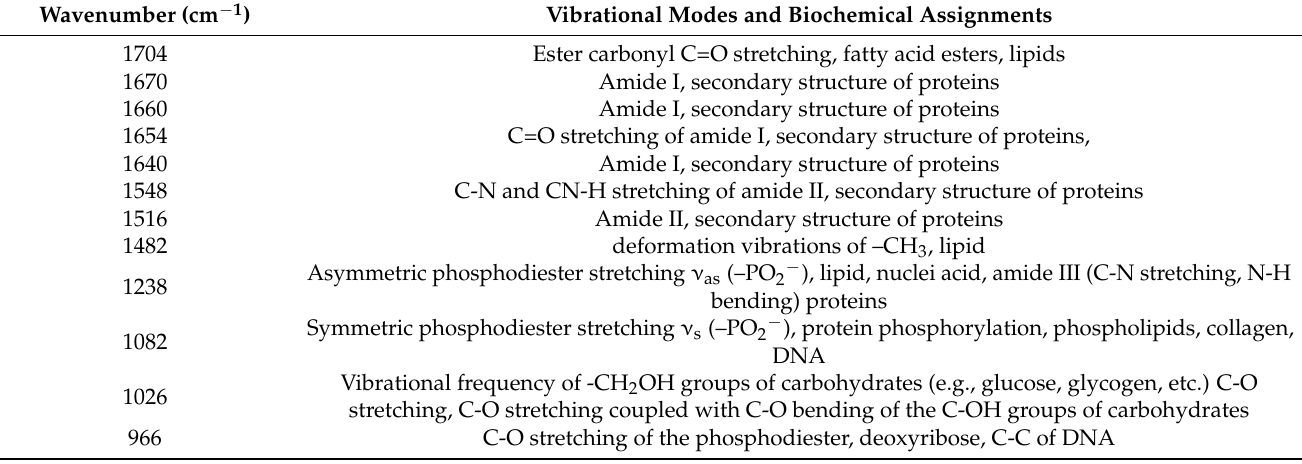
Figure 7. ( a ) Receiver operating characteristic (ROC) curves with area under the curve (AUC) values (AUC = 1); ( b ) sensi- tivity and specificity curves vs. threshold; and ( c ) confusion matrix for the partial least square discriminant analysis (PLSDA) model. TPR is true positive ratio, FPR is false positive ratio, TNR is true negative ratio, and FNR is false negative ratio.